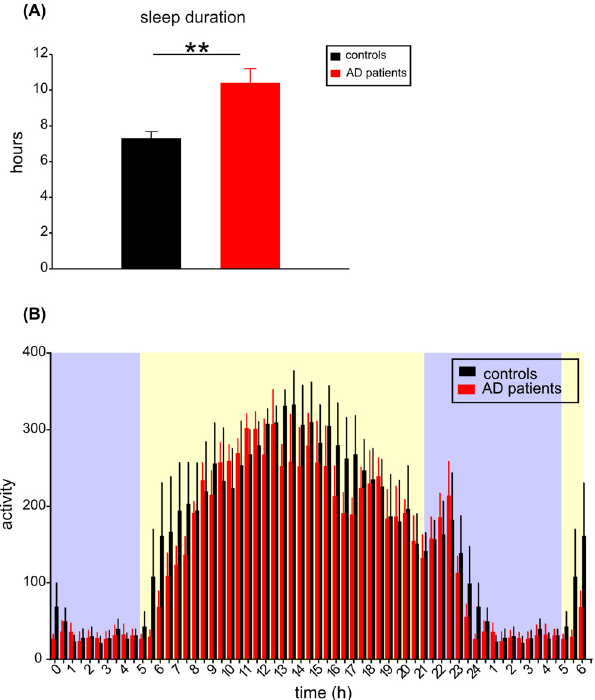
Fig 2. Analysis of sleep and activity rhythms of controls and AD patients. (A) Total sleep duration of the 24-h period (in hours) was assessed by the diary data (mean ± SEM) collected during the 21 day recording period from 13 controls (black column) and 13 AD patients (red column). In AD patients, the mean total sleep duration was significantly longer compared to controls, ** P = 0.002; (B) The mean daily activity profiles of AD patients and controls. The activity was recorded by Actiwatch during 21 days and the cumulated activity levels (mean ± SEM) in 30 min bins throughout the day and night are depicted; for clarity, part of the day (00:00 to 06:00 h) was re-plotted. The activity levels in 4 controls (black columns) and 4 AD patients (red columns) are depicted. The blue and yellow areas on the graph background correspond with time of the environmental darkness and daylight, respectively, as occurred during the recording period. X axis represents clock time (hours). For more details, see Material and